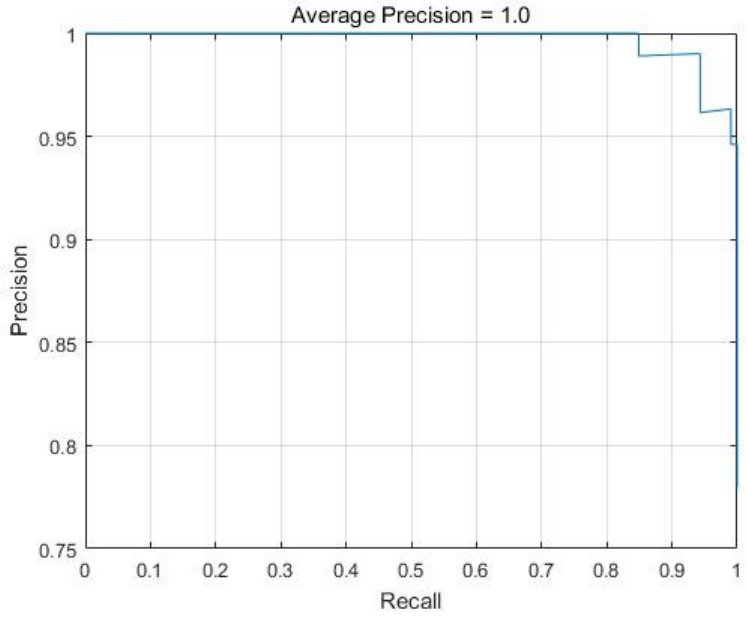
Figure 4. The Precision versus Recall curve of the sea clutter detection in Faster R-CNN.